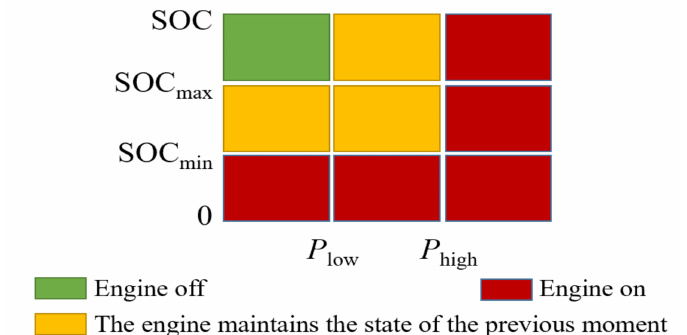
Figure 11. Operating principle diagram of power follower control strategy